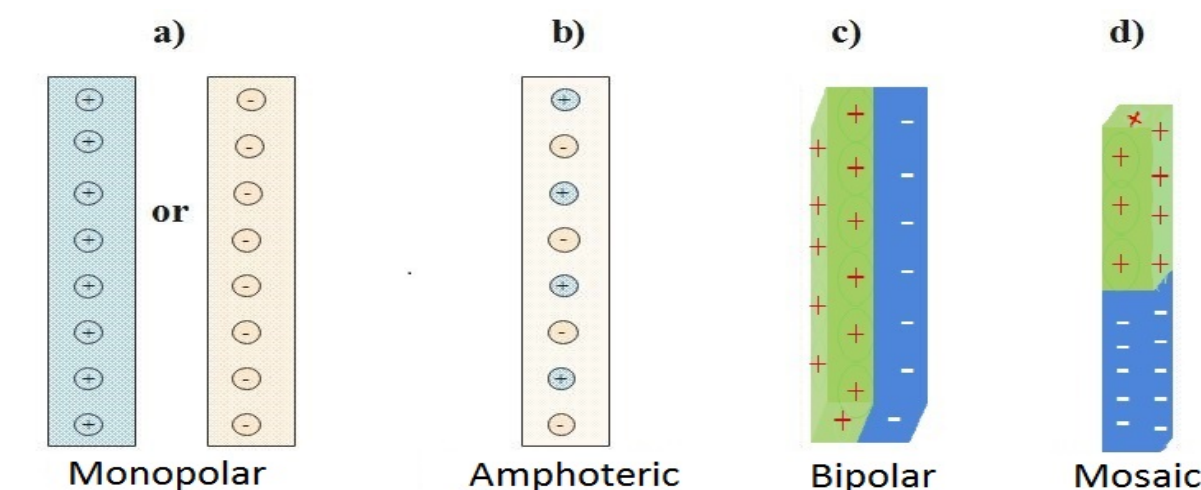
Figure 1. Categorized ion exchange membranes. ( a ) Positive or Negatively charged monopolar IEM, ( b ) Amphoteric IEM, ( c ) Bipolar IEM and ( d ) Mosaic IEM adapted from [49,50].